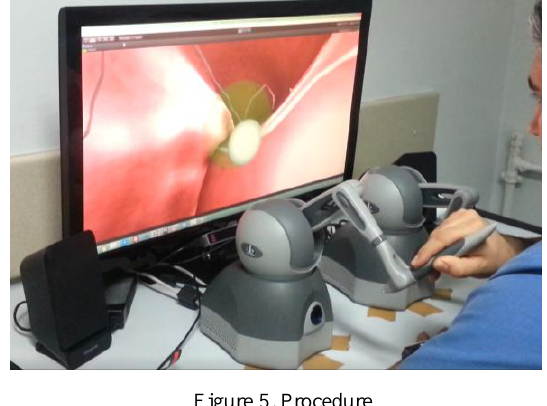
Figure 5. Procedure